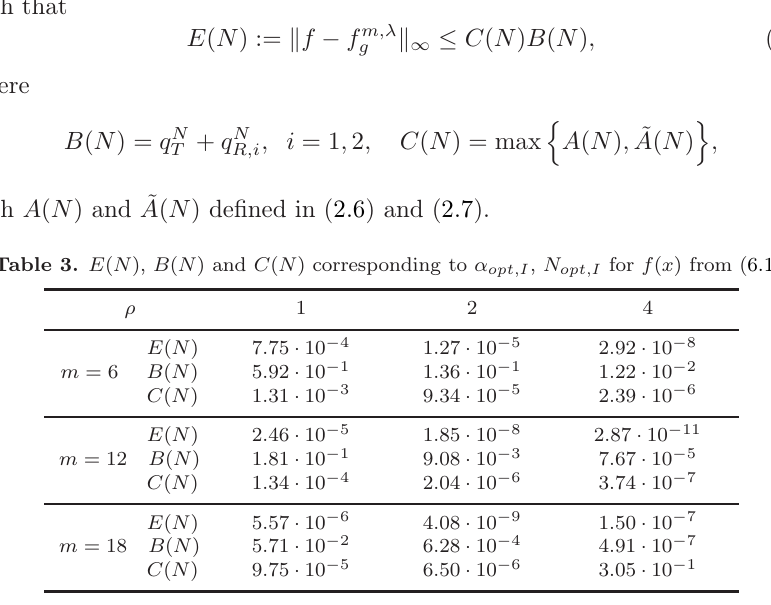
Table 4. E ( N ) , B ( N ) and C ( N ) corresponding to α opt,ρ , N opt,ρ for f ( x ) from (6.1).